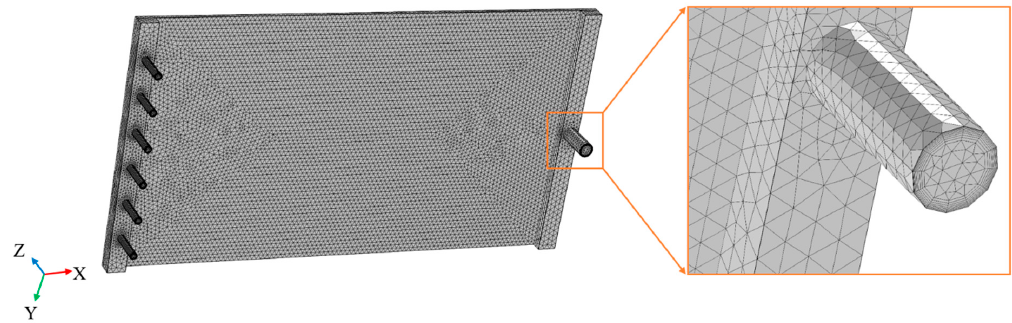
Figure 4. Mesh situation of the membrane chamber.